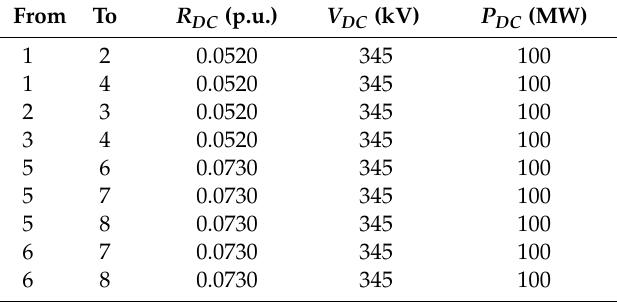
Table A32. Parameters of the DC